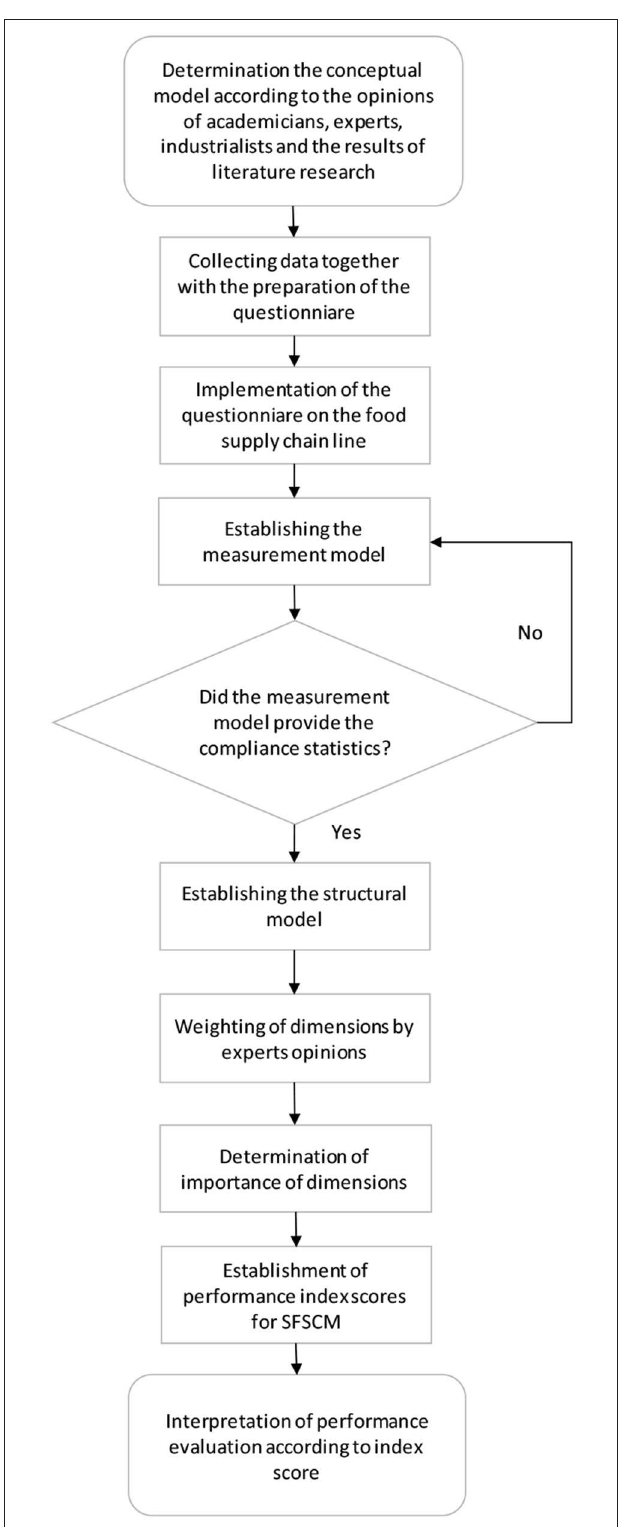
FIGURE 2 | Conceptual model of the proposed research